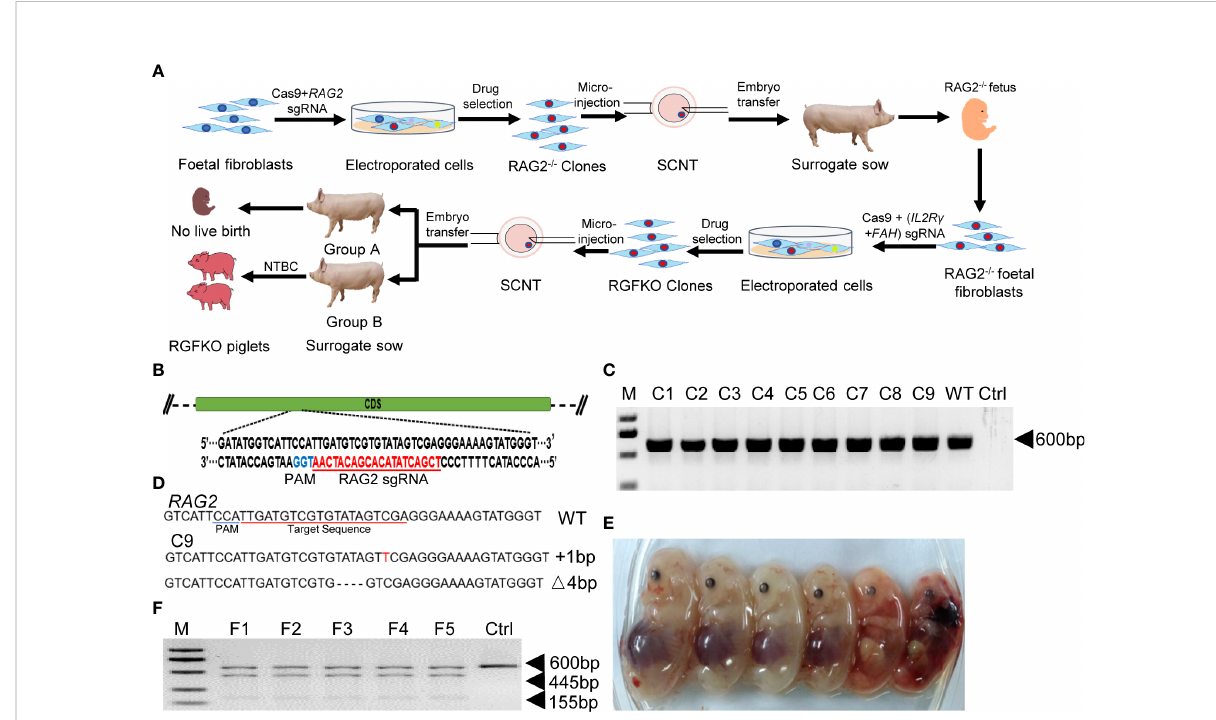
FIGURE 1 Targeted disruption of RAG2 by CRISPR/Cas9. (A) Schematic representation of the work fl ow to generate RGFKO pigs. RAG2 -/- IL2R g -/Y FAH -/- (RGFKO) pigs were generated through sequential mutation of the RAG2 gene to generate RAG2 -/- fetus fi rst followed by mutations of IL2R g and FAH genes to generate triple knockout RGFKO pigs. To mutate the targeted gene(s), single guide RNA (sgRNA) targeting the respective gene(s) was fi rst designed. Day 33 fetal fi broblasts were then electroporated with sgRNA and Cas9 plasmids, followed by drug selection. Positive